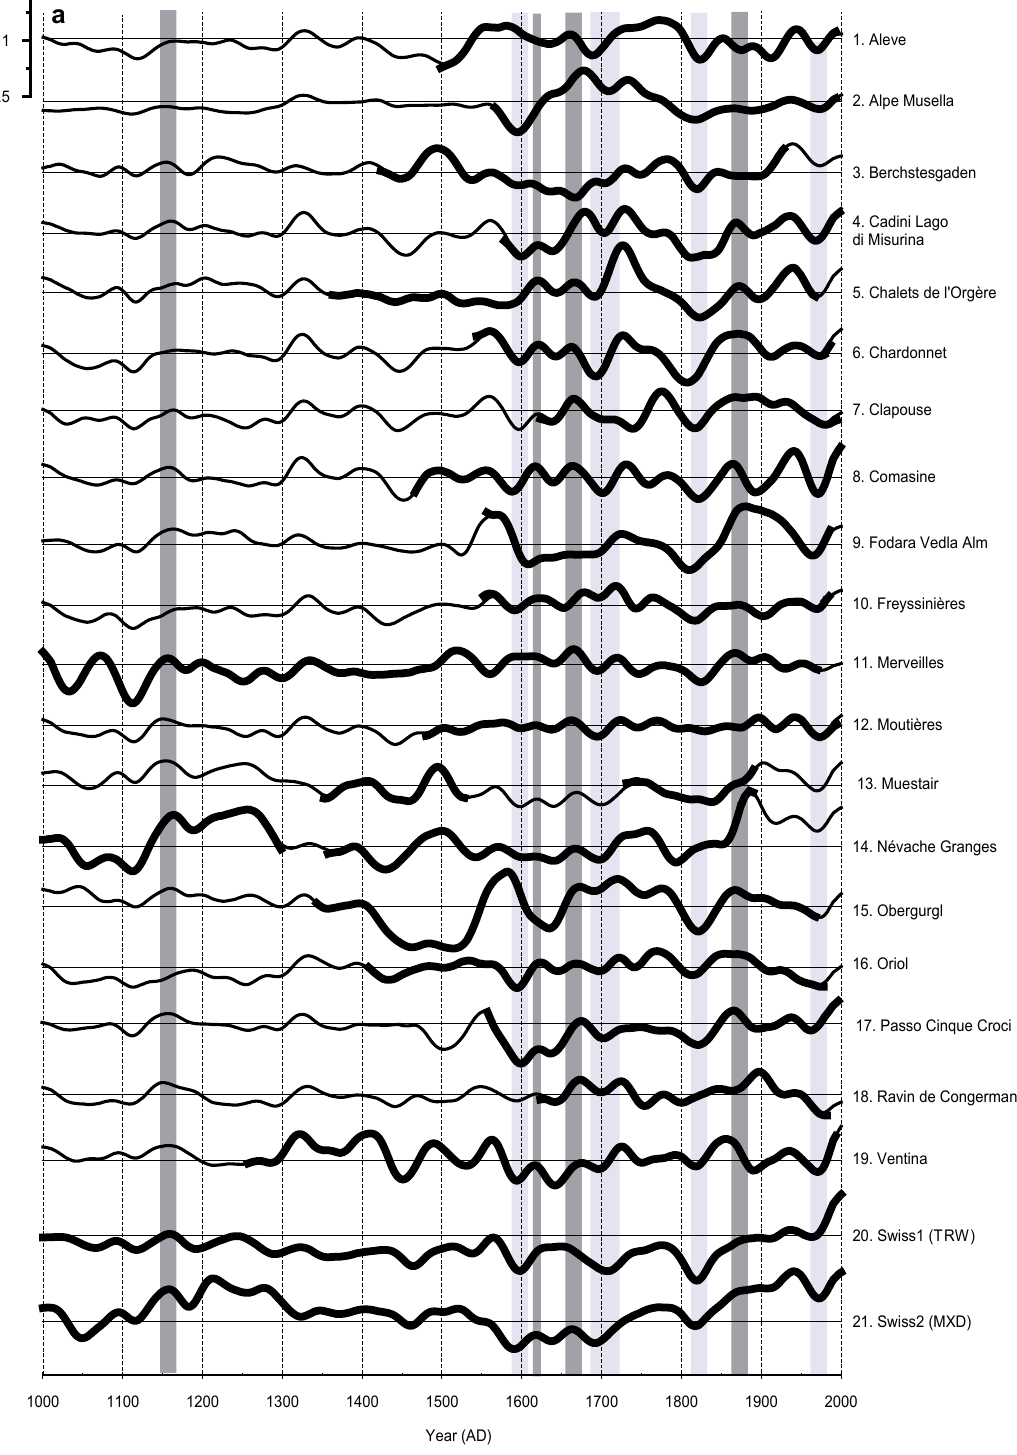
Fig. 2a. Missing data estimation by the analogues method (thin line) and comparison with the original series (thick line). (a) Larch series; (b) Pine series. Original series are detrended using the Adaptative Regional Growth Curve (ARGC) method. All series are smoothed with a 20-year lowpass filter. Dark-grey shading denotes a period of increasing growth, light-grey shading reveals period of growth reduction.